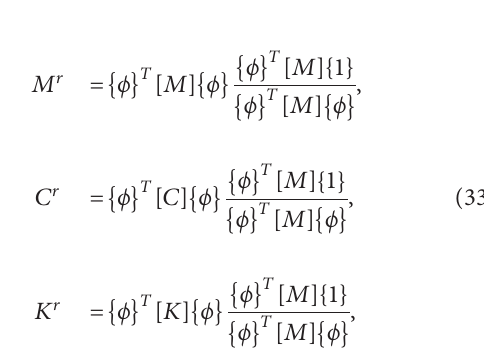
� 0.30; (b) α � 0.50; (c) α � 0.70; (d) α �